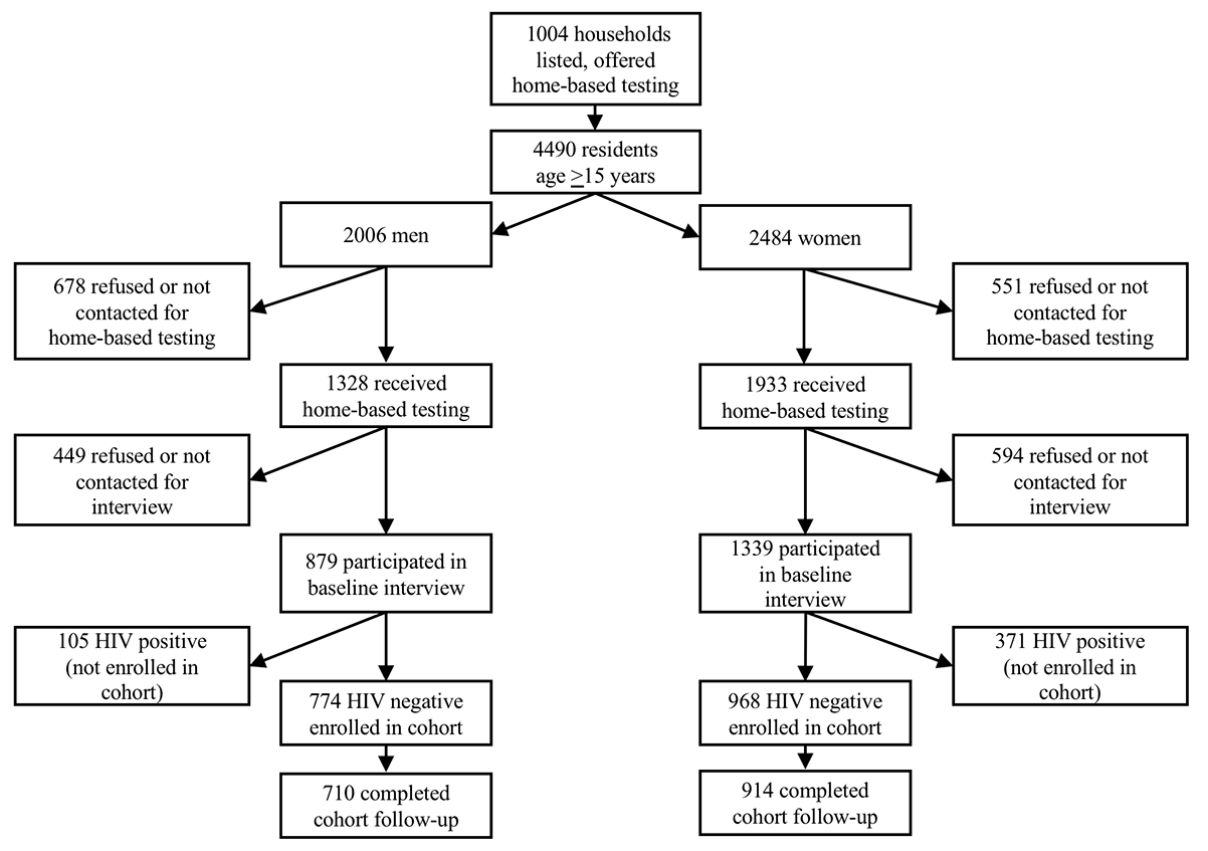
Figure 1. Flow diagram of household listing, receipt of home-based HIV testing, participation in the cohort study and follow-up measurements